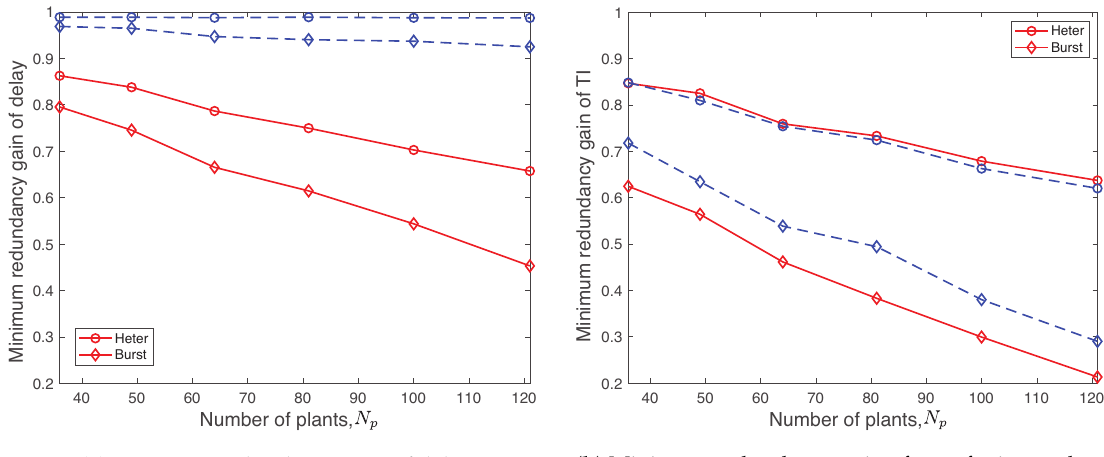
Figure 17. Minimum redundancy gains of delay and transfer interval of three classes using R-WSAN and the centralized protocol with heterogeneous and burst links as a function of different number of plants N p = 36, . . . ,121. R-WSAN efficiently adapts the network resources for heterogeneous control